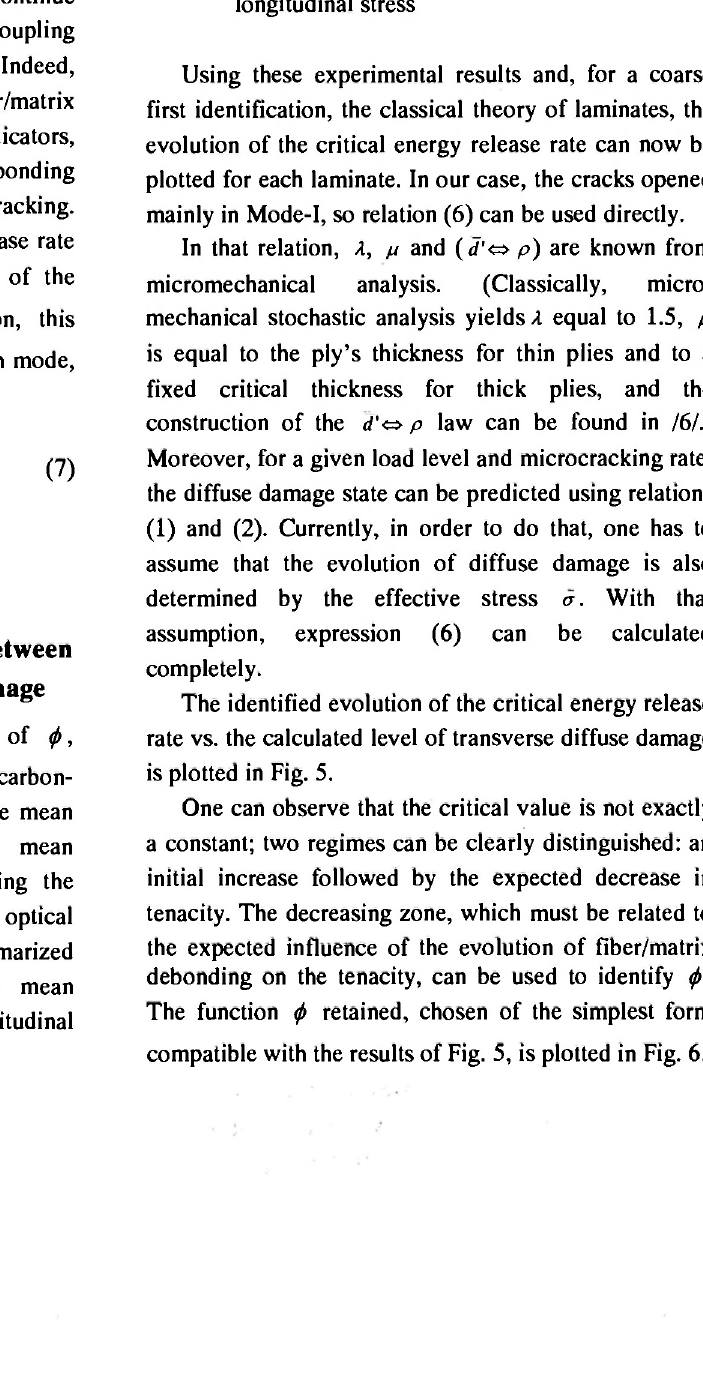
Fig. 4: Microcracking rate on the edge vs. the mean longitudinal